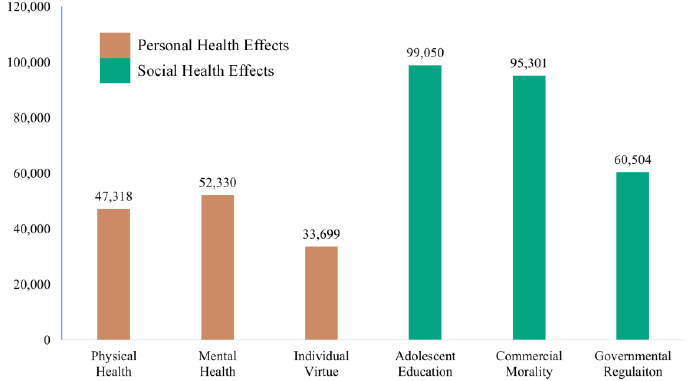
Figure 4. Consumer concern degree of each topic.